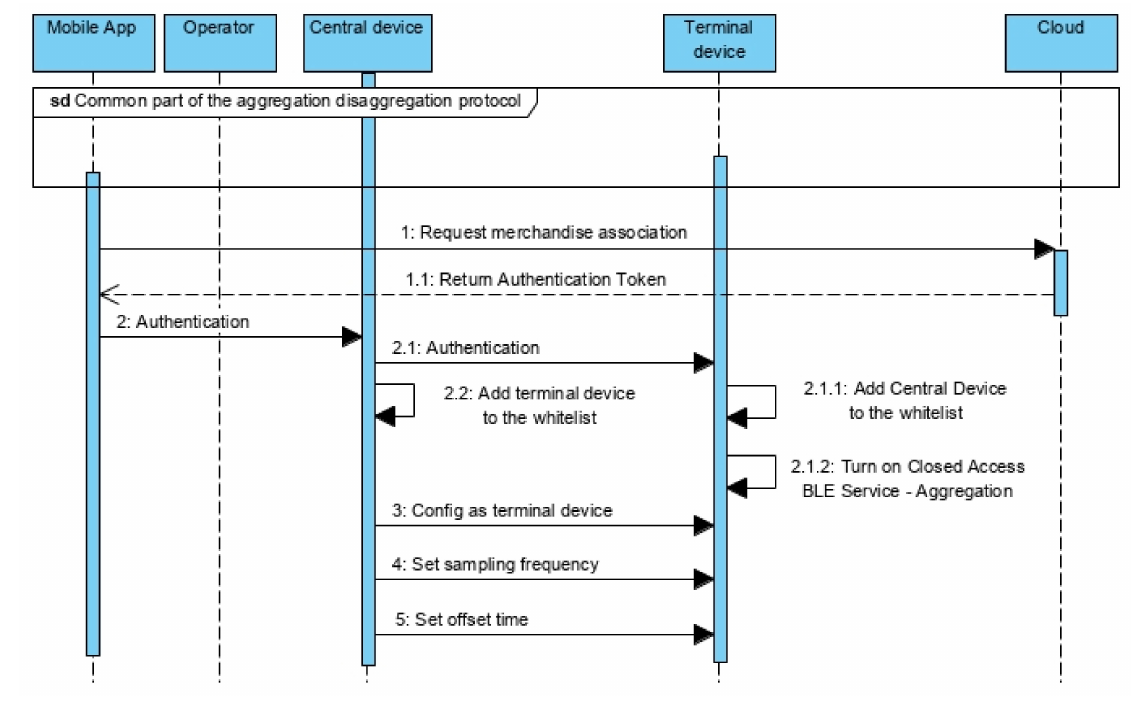
Figure 11. Aggregation